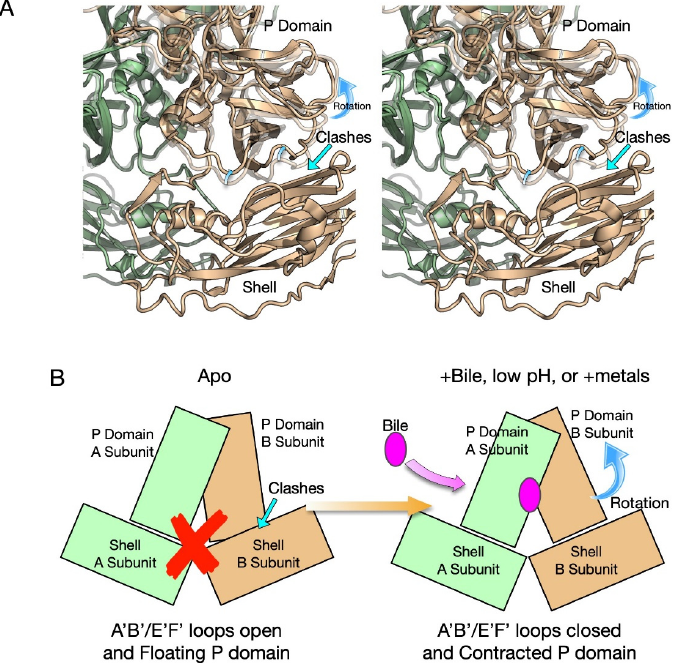
Figure 5. Rotation of the A/B P domains and resulting contraction onto the shell. ( Panel A ) shows a stereo ribbon diagram of the unrotated A/B dimer (open conformation) modeled onto the A/B dimer in the contracted, closed conformation observed in the low pH and bile complex structures. The open conformation (unrotated) is shown as a transparent image and the closed conformation in solid colors. Note that the P1 domains of the A subunit (light green) were used for the alignment process and therefore match well. However, this places the P1 domain of the B subunit in the open conformation too close to the shell and, hence, why the P domain in the open conformation (unro- tated) cannot rest on the shell. ( Panel B ) shows a schematic representation of the structures shown in ( A ). Before the A/B subunit rotation, the surface of the P domain base is not complementary to the shell surface and the P domain is not able to rest upon the shell (red X). This changes upon rotation of the A/B subunits, where the base of the P domain dimer changes and forms a comple- mentary surface to the top of the shell, thus allowing the P domain to rest upon the shell. From the analysis of all structural information collected to date, this rotation/contrac- tion seems likely governed by the movement in the C’D’ loop that, in turn, is linked to the G’H’ loop. This correlation is made evident when all the conditions and structures are compared (Table 1). In the original apo crystal structure of the isolated P domain, the A’B’/E’F’ loops were observed to be in both the open and closed conformations but the C’D’ loop was in the down position. We hypothesized that the A’B’/E’F’ loops were free to exist in both conformations without the C’D’ loop pressing against them [37], and the C’D’ loop could be in the down position only if the G’H’ loop had the vertical confor- mation [20]. Importantly, the A/B subunits were not rotated about each other as observed when bile, low pH, or metals are added. From EM studies of the whole virus under the same conditions, the P domain is floating above the shell and highly mobile, and therefore, the conformation of the loops in that structure is not known to high resolution. However, the crystal structure of the P domain (lines 1 and 2) and the EM structure of the P